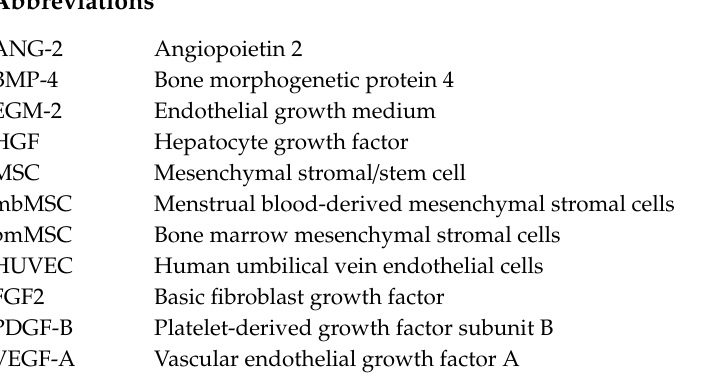
Figure S1: Umbilical cord vein endothelial cell lineage EA.Hy926 maintained morphology, phenotype and functional properties in vitro. Table S1: Primers used in order to evaluate angiogenic-related molecules. Video S1: mbMSC migration on scratch wound assay. Video S2: bmMSC migration on scratch wound